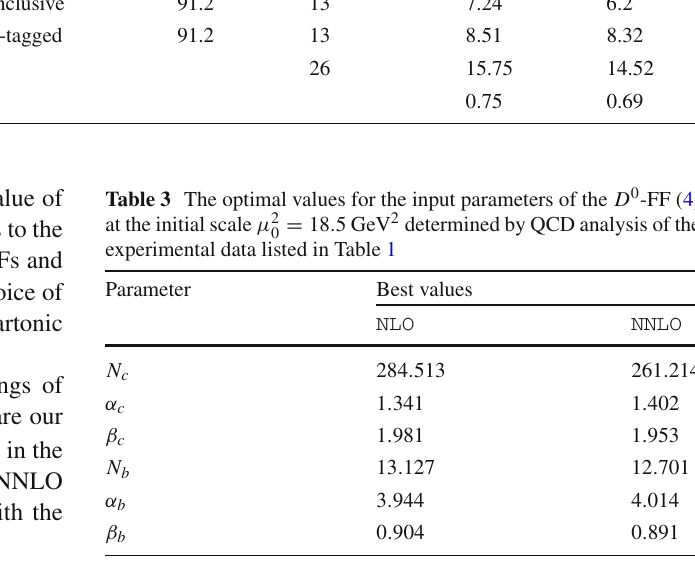
Table 2 As in Table 1, but for D +